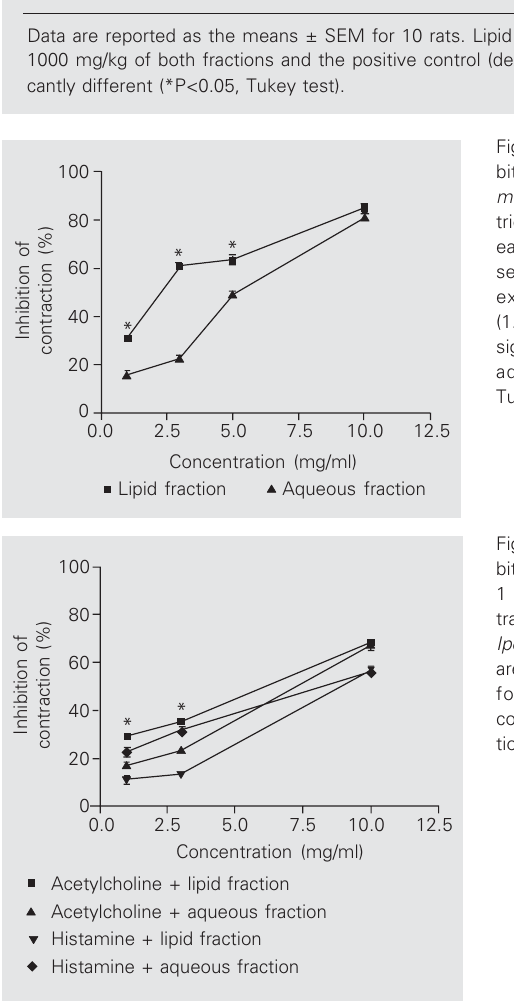
Figure 3. Dose-dependent inhi- bition of 1 µM acetylcholine- and 1 µM histamine-induced con- tractions in guinea pig ileum by Ipomoea imperati extracts. Data are reported as means ± SEM for 5 experiments. *P<0.05 compared to the aqueous frac- tion (Tukey test).